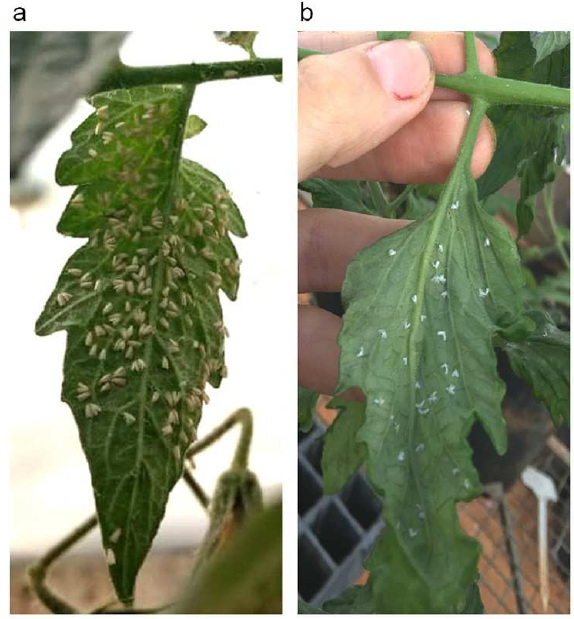
Figure 3. Level of adult whitefly infestation in genotypes selected for contrasting levels of zingiberene. ( a ) refers to the genotype RVTZpl#125 with low content of the allelochemical, and ( b ) refers the genotype RVTZpl#348 with high content of the allelochemical.